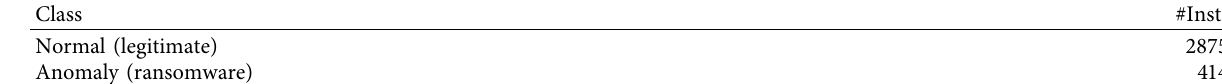
Table 2: Legitimate and ransomware bitcoin transactions.